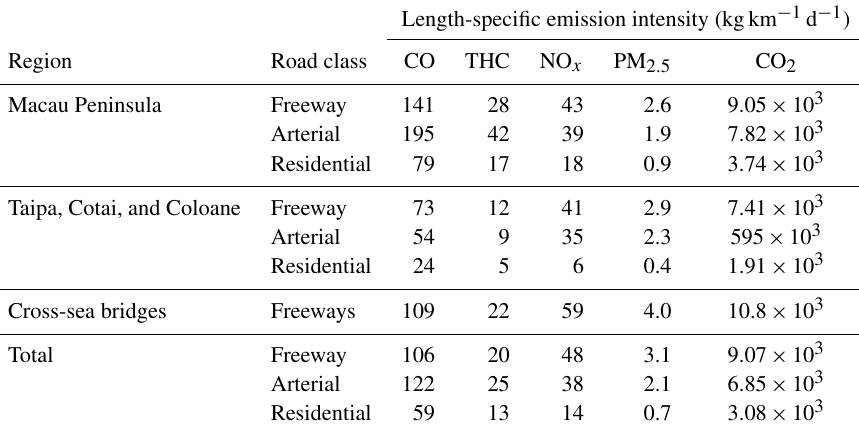
Table 5. Length-specific emission intensity of total vehicular emissions during a typical weekday of 2010.